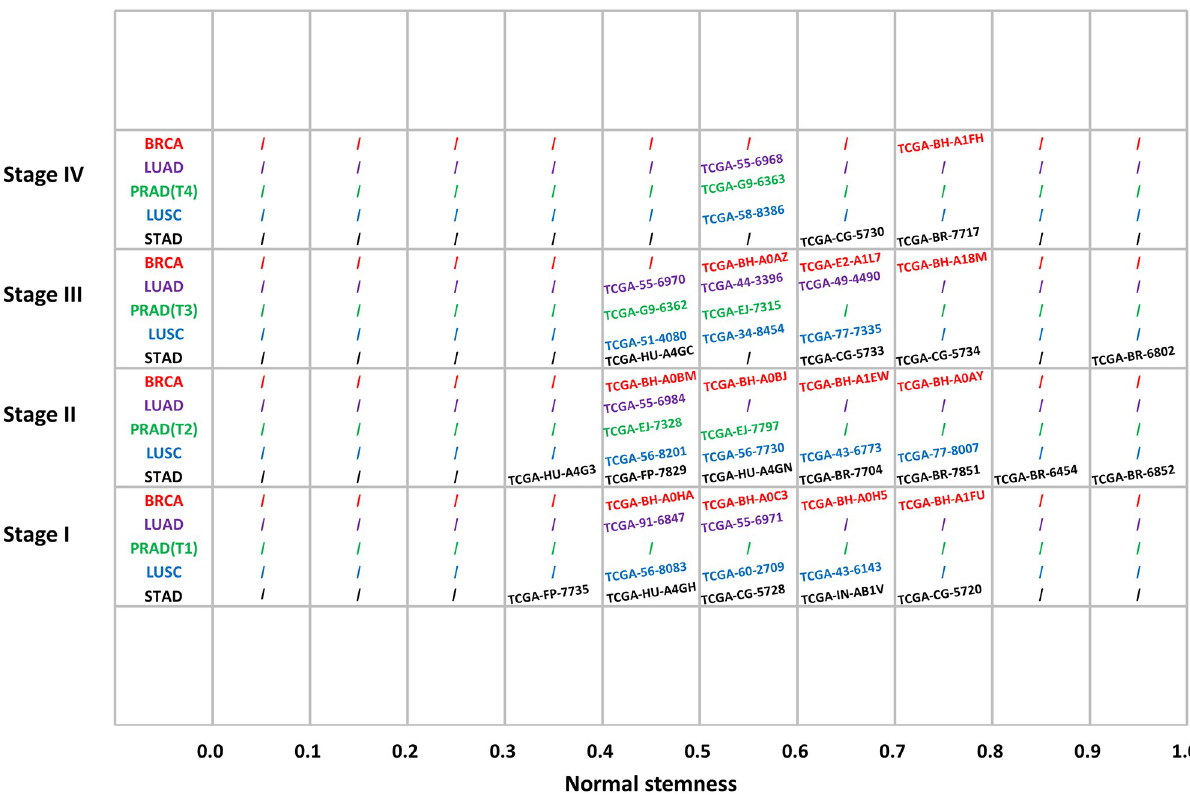
Fig 6. TCGA Sample IDs of five tumors sampled in Normal stemness (0–1) and cancer stage (stage I–stage IV, or T1–T4) grids. Red: BRCA (Breast invasive carcinoma); Purple: LUAD (Lung adenocarcinoma); Green: PRAD(Prostate adenocarcinoma); Blue: LUSC(Lung squamous cell carcinoma); Black: STAD(Stomach adenocarcinoma); ‘/’: There is no eligible TCGA Sample ID in this